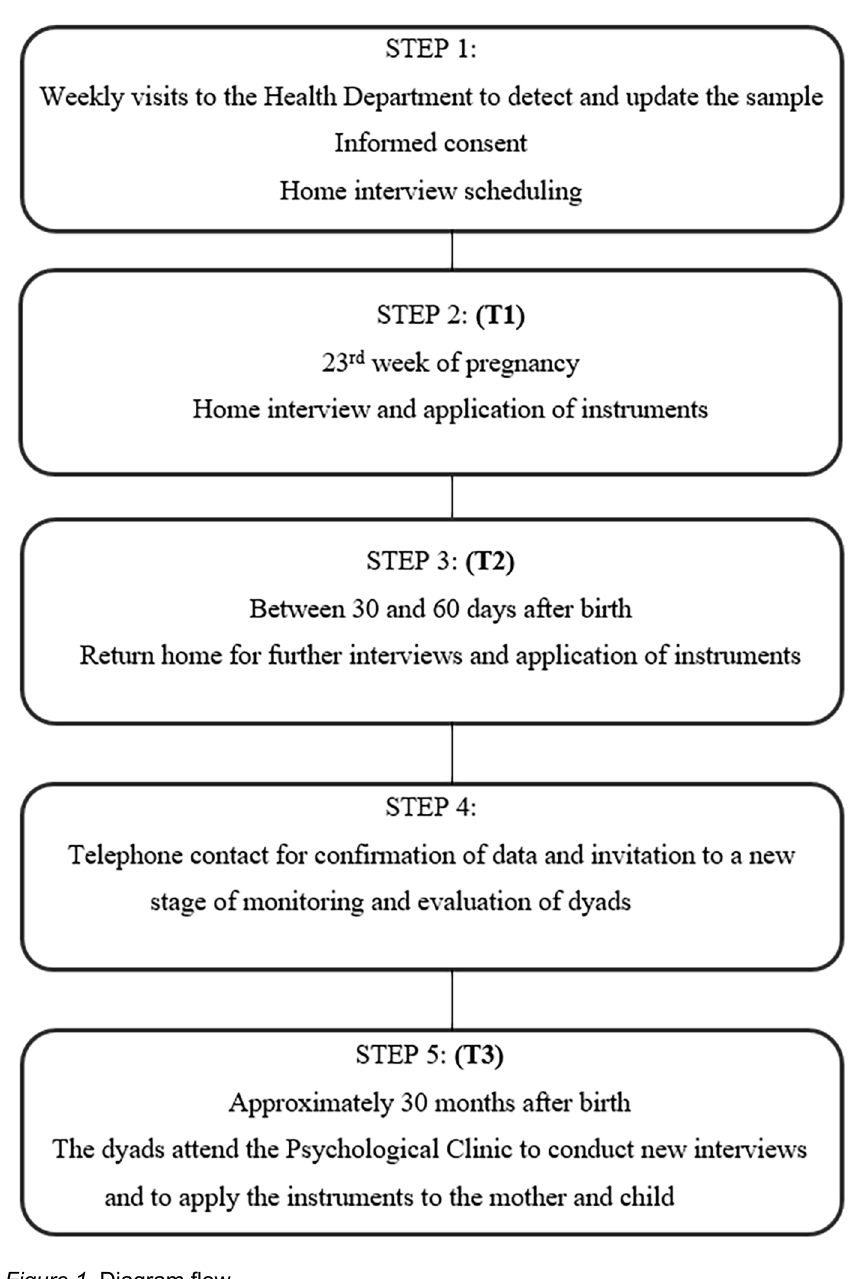
Figure 1. Diagram